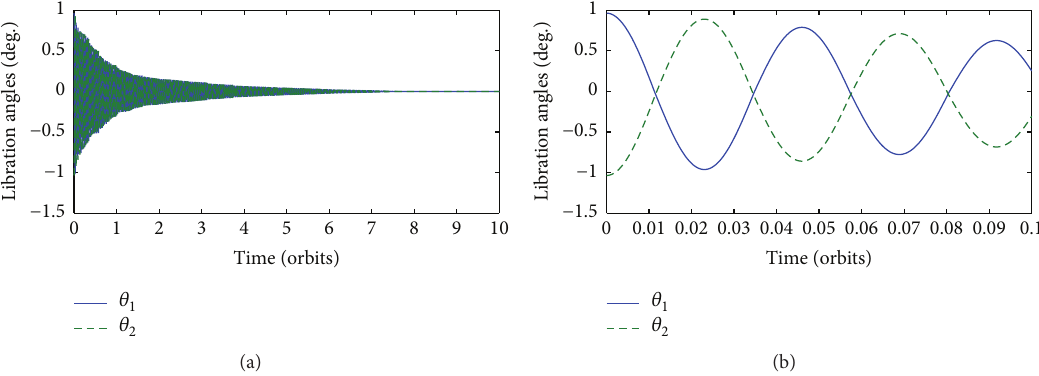
Figure 22: Libration angles from the formulations based on point 𝐶 by applying the SDRE control with 𝛼 = 10 −6 for (a) the first 10 orbits and (b) the first 0.1